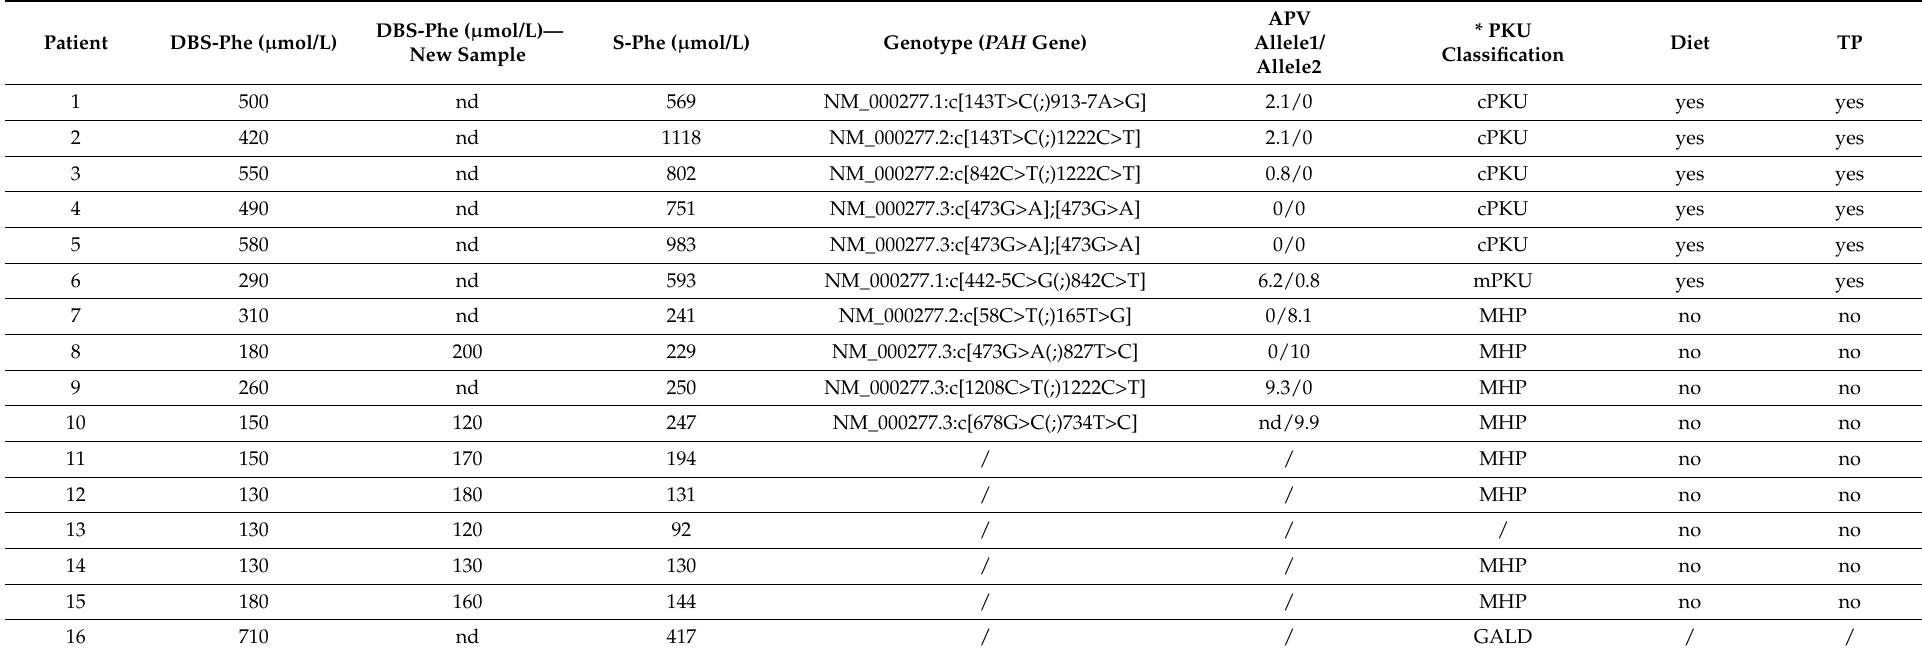
Table 1. Phe values, genotype, and diagnosis of 16 newborns who needed PKU confirmatory